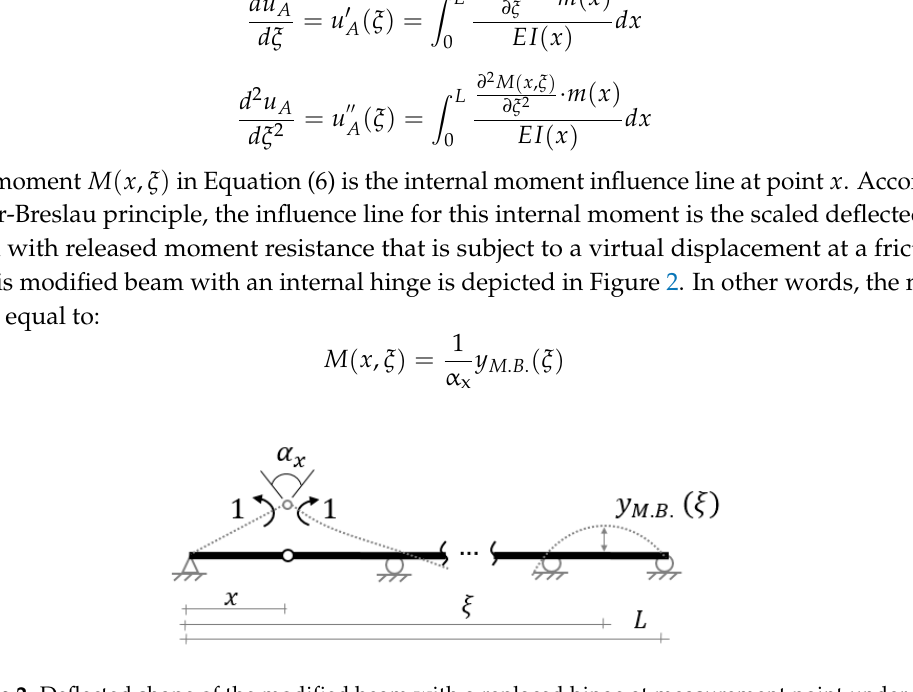
Figure 2. Deflected shape of the modified beam with a replaced hinge at measurement point under the effects of a virtual displacement.